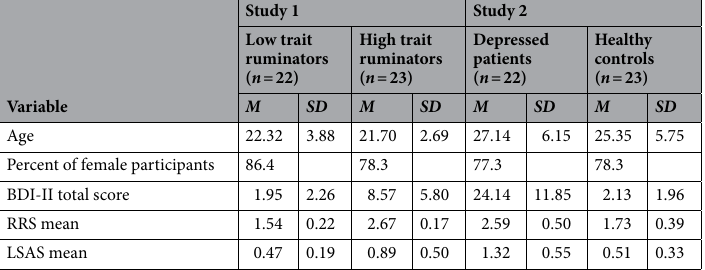
Table 4. Demographic variables of the samples. BDI-II Beck Depression Inventory II 58 , RRS Rumination Response Scale 9 , LSAS Liebowitz Social Anxiety Scale 86 .